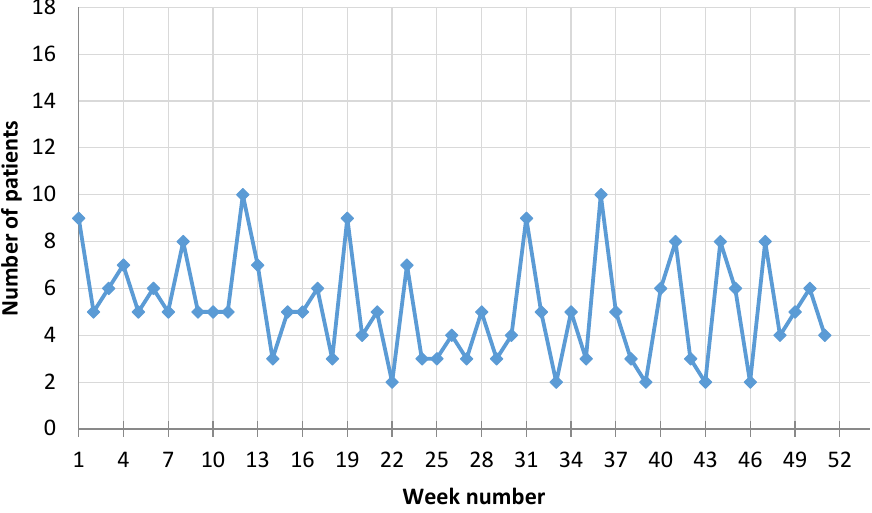
Figure 4. Number of women admitted with MI in each week during 2016.